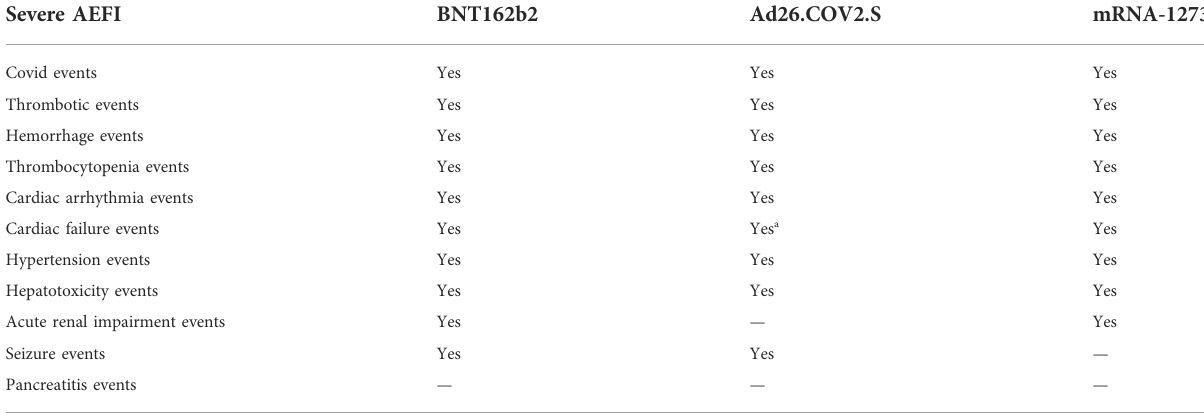
TABLE 1 Severe AEFI associated with the BNT162b2, Ad26.COV2.S, and mRNA-1273